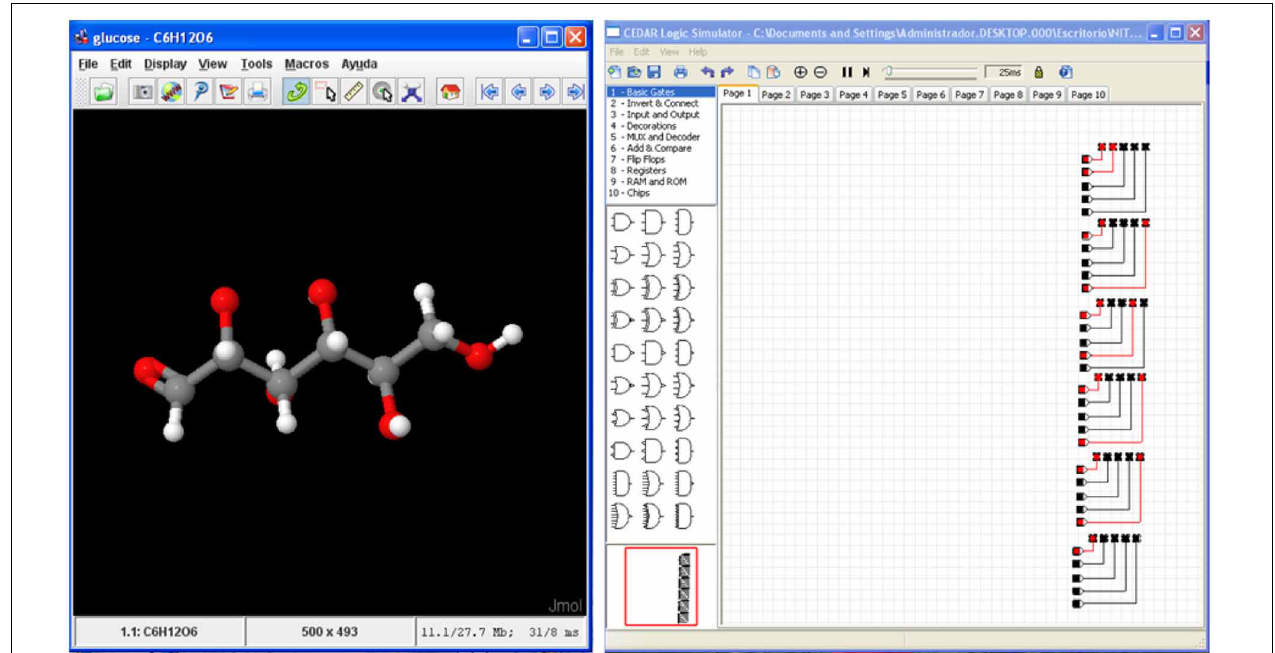
FIGURE 5 | Glucose molecule (Left) and its hardware version as a matrix of LEDs (Right) simulated with CEDAR Logic Simulator (Recio Rincon et al., 2013).